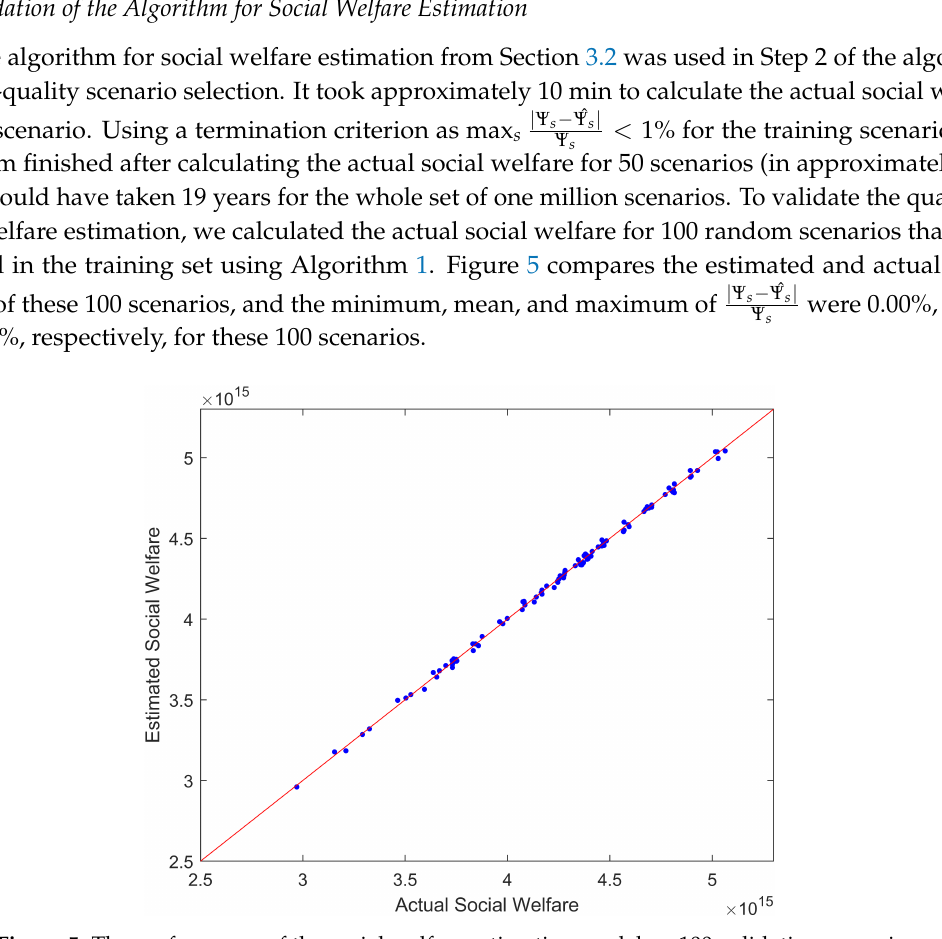
Figure 5. The performance of the social welfare estimation model on 100 validation